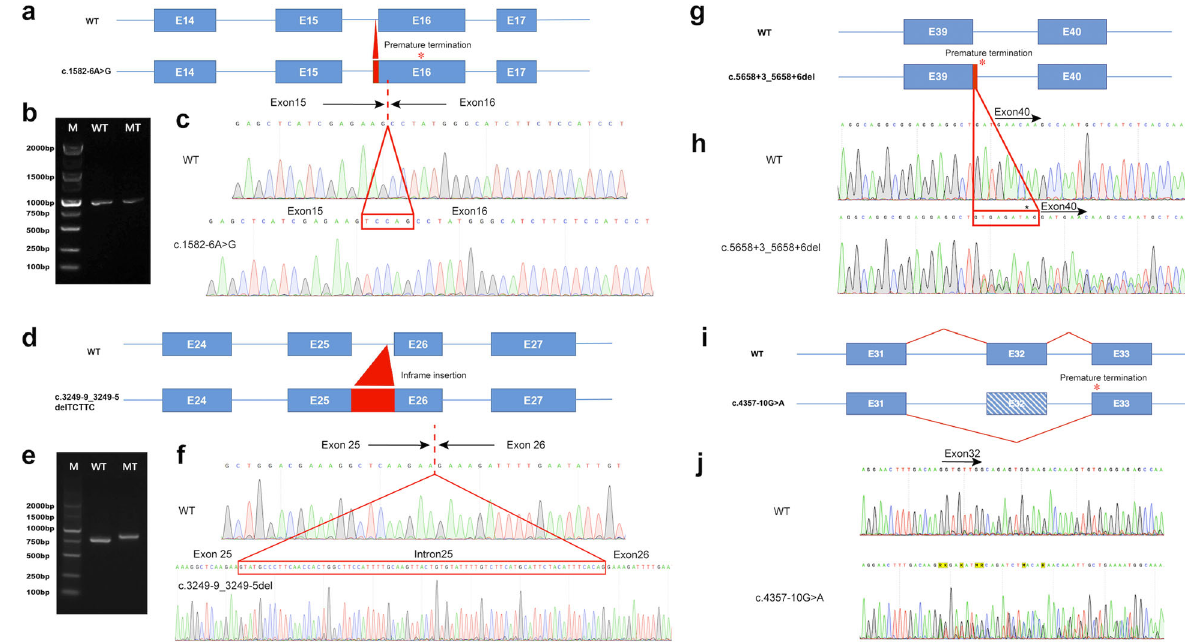
Fig. 5 Analysis of the MYH3 splicing abnormalities in families D, E, F, and J. a Schematic representation of the effect of c.1582 − 6A>G in Family D. b Agarose gel electrophoresis does not show difference in the product size because the length difference of the products is only 5 bp. c The c.1582-6A>G leads to an insertion of 5-bp of intronic sequence before exon 16, leading to a frameshift. d Schematic representation of c.3249-9_3249-5delTCTTC on molecular consequences on cDNA in family E. e Agarose gel electrophoresis illustrating the effect of the splicing variant c.3249-9_3249-5delTCTTC with a larger fragment size in the mutant allele. f Note that the pathogenic variant leads to retention of intron 25, and an in-frame insertion. g Schematic representation of c.5658 + 3_5658 + 6del molecular consequences on cDNA in family F. h Sanger sequencing of cDNA from the affected individual and her healthy parents shows that the c.5658 + 3_5658 + 6del leads to 9 bp intron retention between exon 39 and exon 40. In silico translation tool in SIB ExPASy Bioinformatics Resources Portal predicts a 9 bp inclusion, adding two amino acids followed by a termination codon annotated by * in the picture. i Schematic representation of c.4357-10G>A molecular consequences on cDNA in family J, showing that the variant leads to exon 32 skipping. j Sanger sequencing of cDNA from the affected individual shows end of exon 31 (single peaks in the chromatogram) and its boundaries to exon 32 and 33 respectively at the start of double peaks in